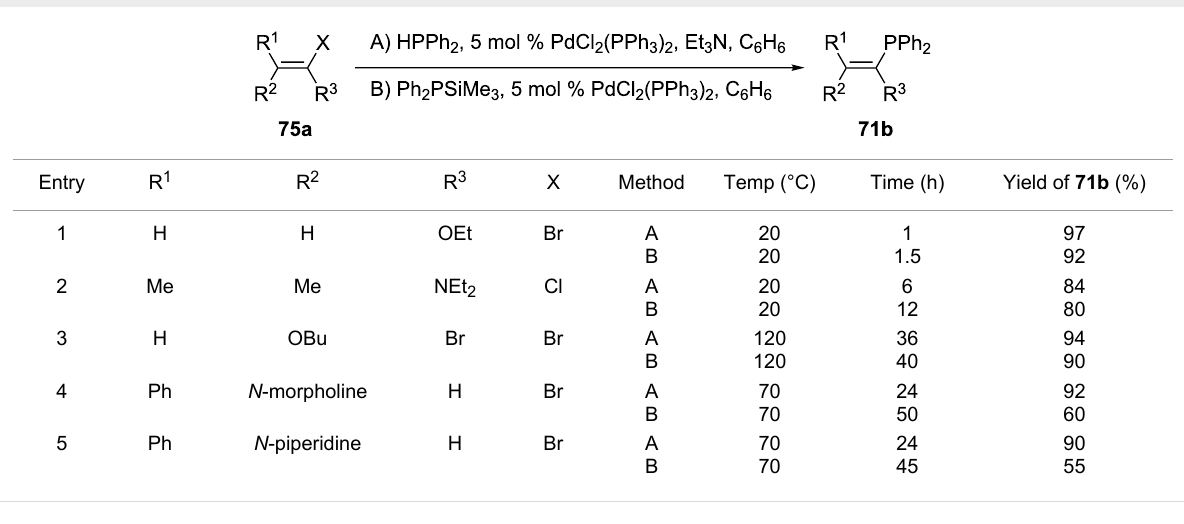
Table 6: Pd-catalyzed cross-coupling reactions of diphenylphosphine with alkenylhalides 75a .